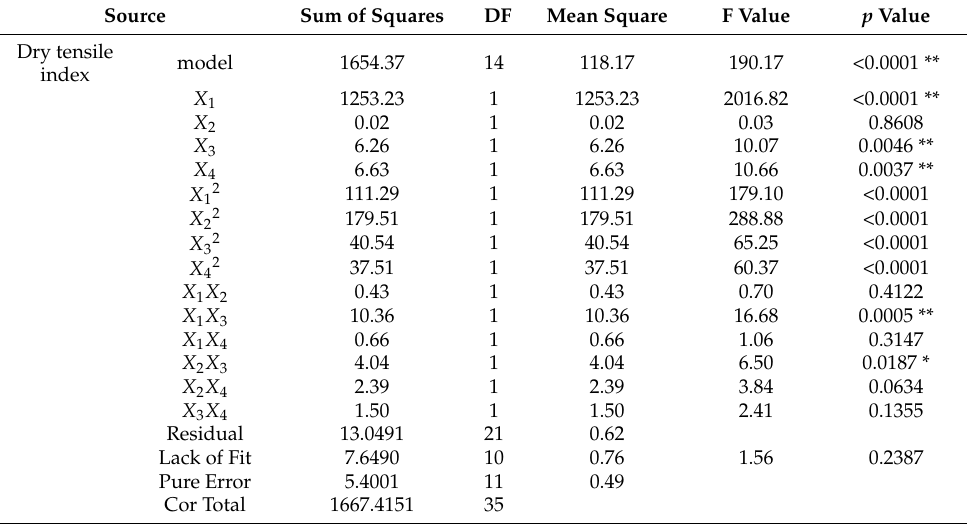
Table 3. Variance analysis of regression model of dry tensile index. Source Sum of Squares DF Mean Square F Value p Value Dry tensile model index